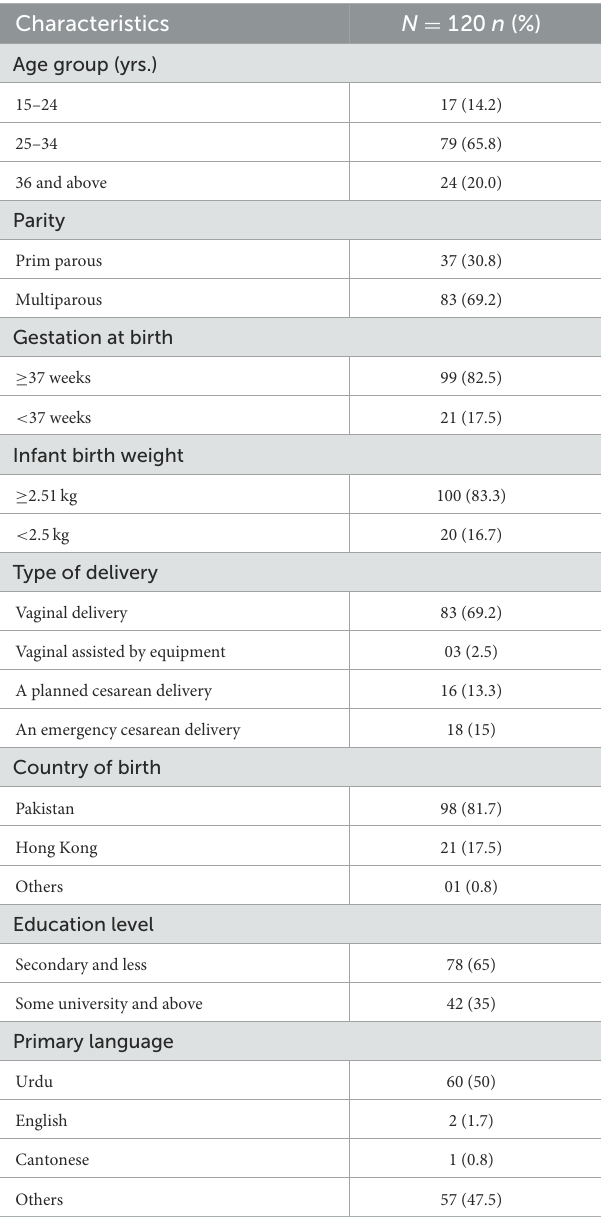
TABLE 1 Characteristics of study